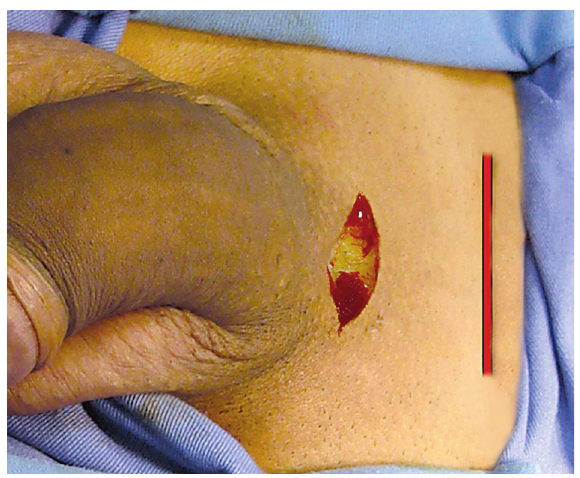
Figure 1 – Suggested incision. The red line sets the relation with the infrapubic incision proposed in the minimally invasive tech- nique described for the three-piece inflatable implants.